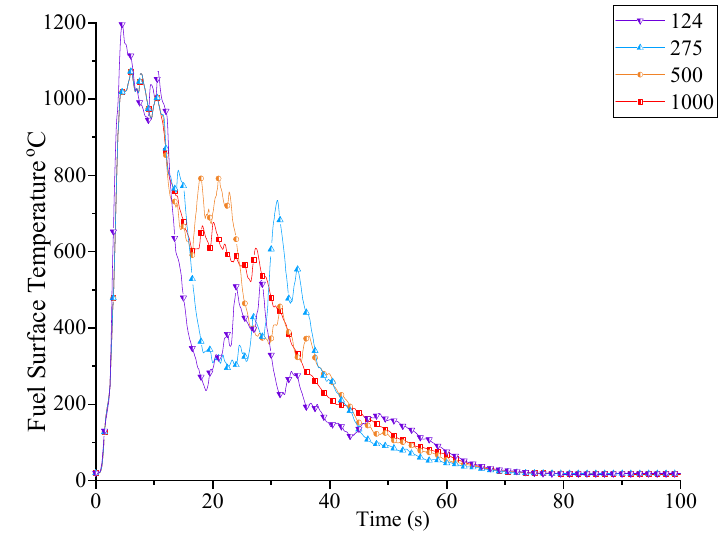
Figure 8. Droplet size and its effect on the fuel surface temperature.